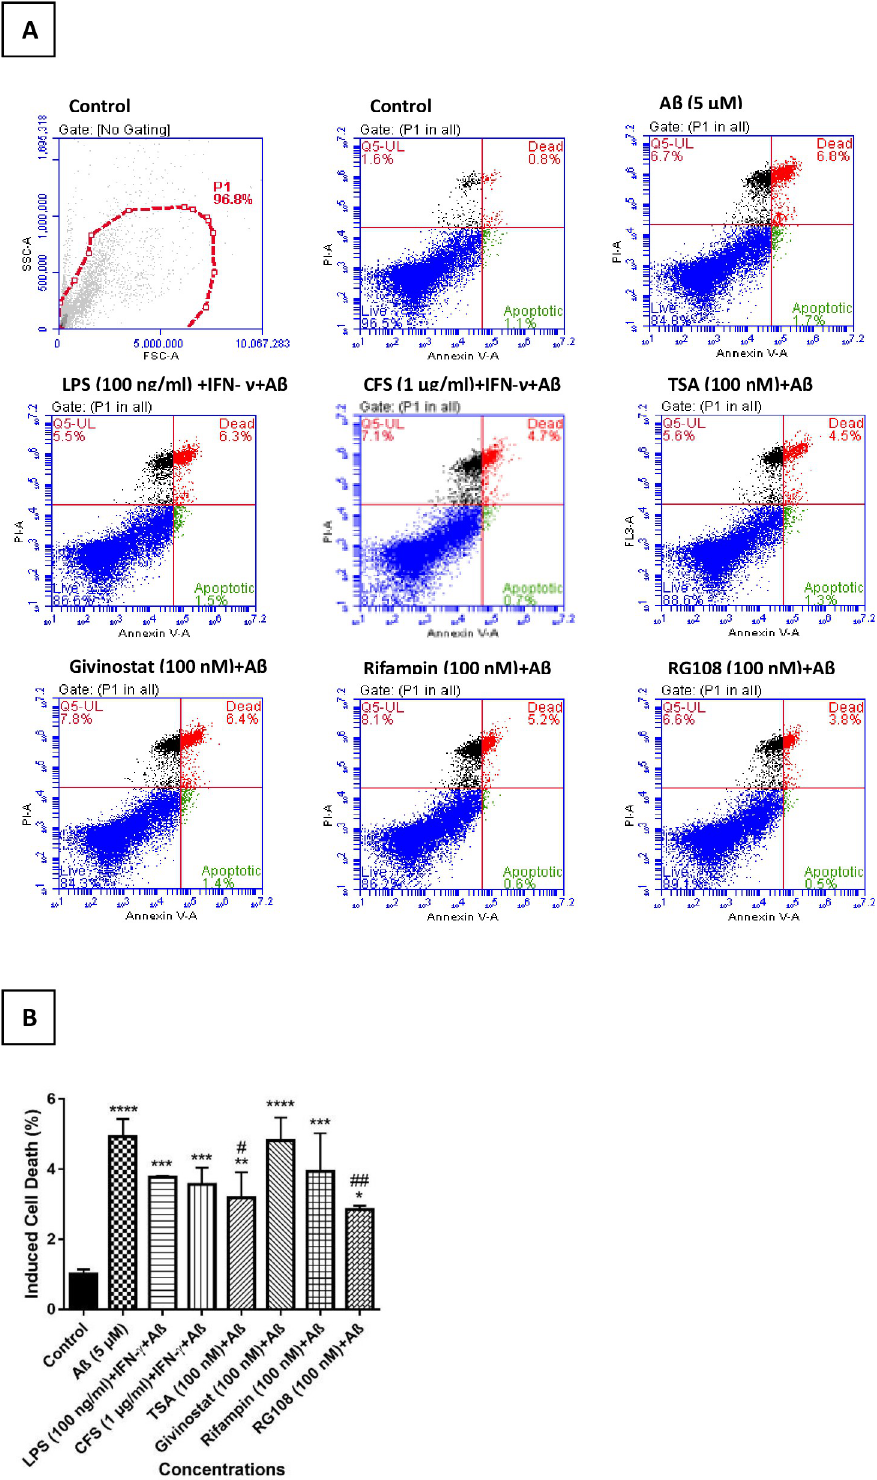
Fig 8. Effects of treatment groups on A β -induced cell death (apoptosis+necrosis) in the presence of 5 μ M A β . (A) The rate of apoptosis/necrosis was measured by flow cytometry using Annexin V/PI staining. Blue dots represent living cells, black dots represent necrotic cells, red and green dots represent cells undergoing late and early apoptosis,